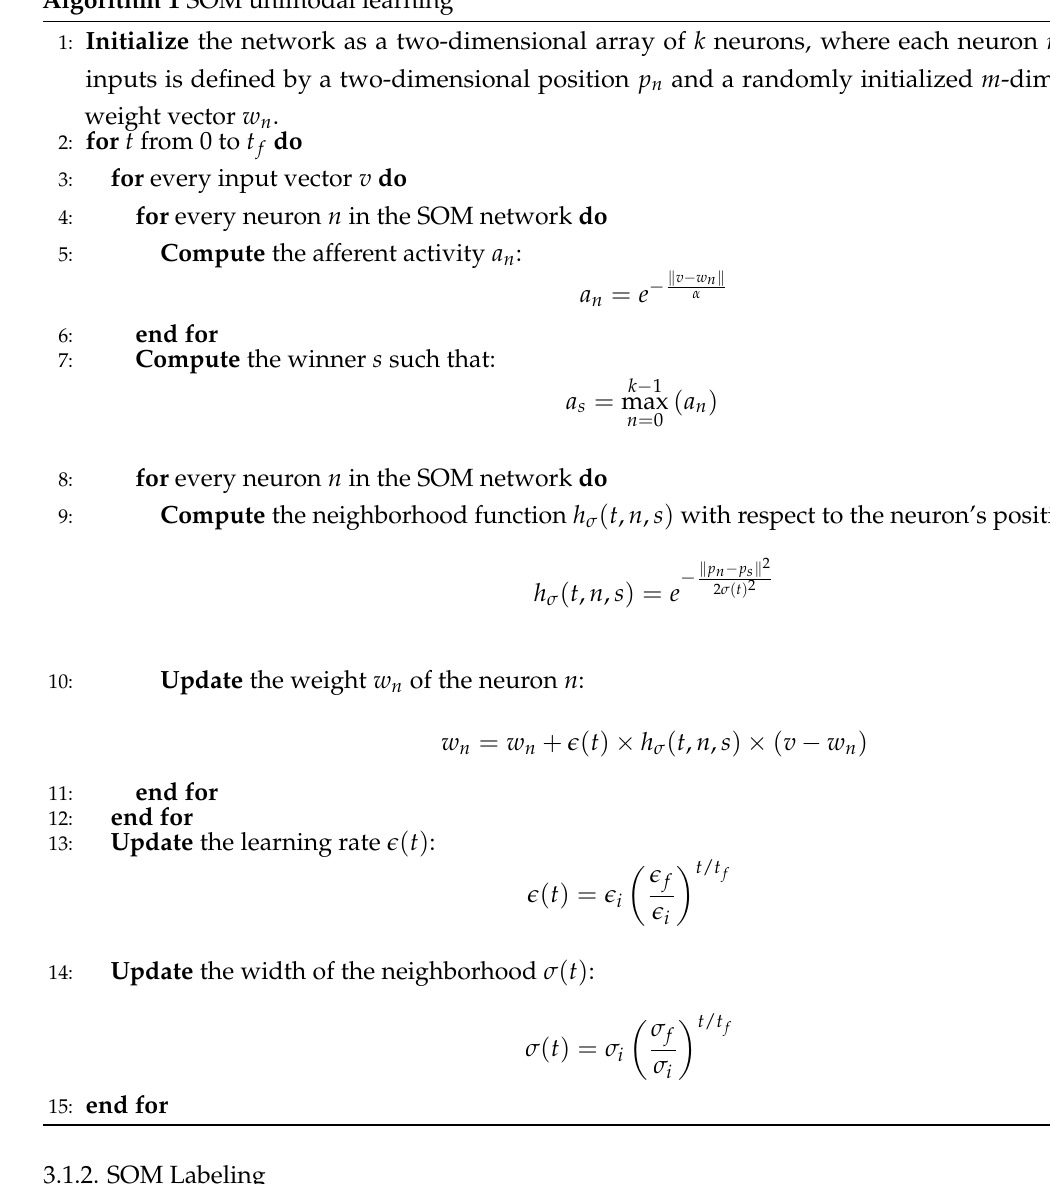
Algorithm 1 SOM unimodal